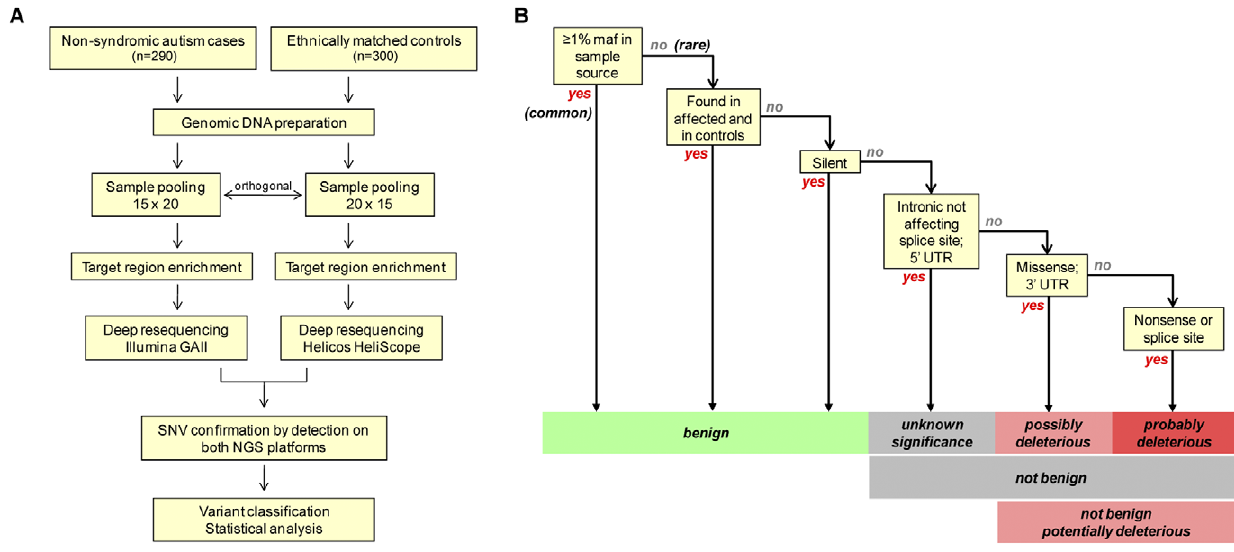
Figure 2. SNV detection and classification. (A) The flow diagram depicts the experimental strategy for SNV discovery and confirmation. For the AGRE and control cohorts, orthogonal multiplexing was performed to prepare two distinct sets of sample pools (15 pools of 20 samples each, or 20 pools of 15 samples each). Following enrichment of exonic target regions for all 18 mGluR pathway genes, SNVs were identified and confirmed by deep resequencing of orthogonal pools on two independent NGS platforms (Illumina GAII and the Helicos HeliScope). SNVs concordantly detected on both platforms were then analyzed as shown in panel B. (B) The flow diagram depicts the procedure used to classify the presumptive functional effects of identified variants. SNVs concordantly detected on both NGS platforms were classified as common or rare using a minor allele frequency (maf) threshold of 1%. Common SNVs, rare SNVs occurring in both autism and control populations, and rare synonymous (silent) SNVs were considered likely to be benign. Rare SNVs in intronic sequences flanking exons that did not affect conserved splice donor or acceptor sites or in 5 9 untranslated regions were classified as not benign but of unknown significance. Rare SNVs causing missense substitutions or occurring in mRNA 3 9 untranslated regions (and therefore possibly affecting mRNA stability or translation [28,29]) were considered possibly deleterious, and rare SNVs causing nonsense mutations or affecting conserved splice donor or acceptor sequences were considered probably deleterious. These latter two categories of SNVs were together considered potentially